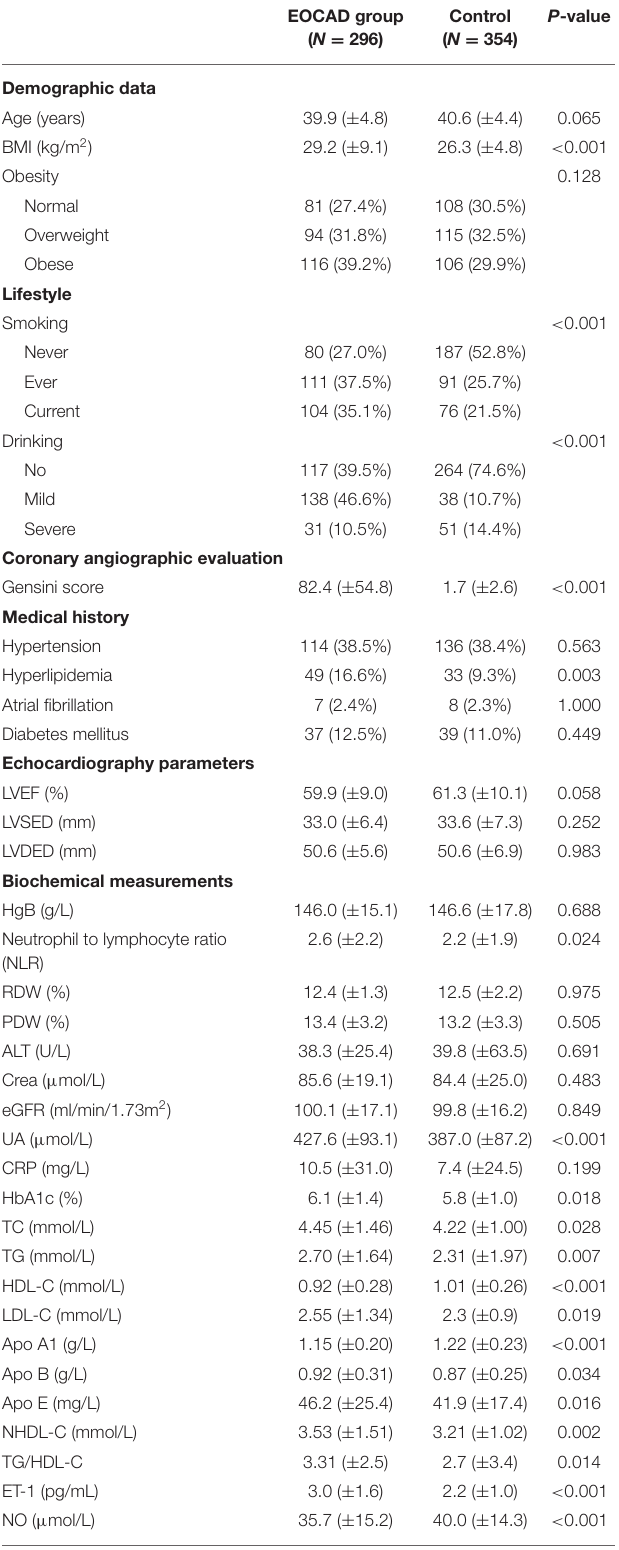
P -value EOCAD group Control ( N = 296) ( N = 354)